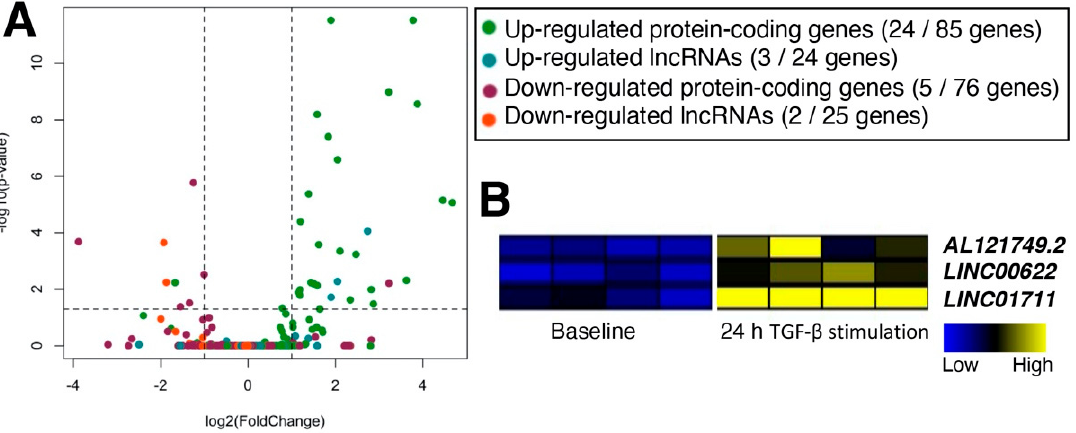
Figure 4. TGF- β -stimulated lncRNAs in cardiac and pulmonary fibroblasts. ( A ) Volcano plot of genes from RNA-seq data of cardiac fibroblasts stimulated with TGF- β for 24 h compared to the CFs before the TGF- β stimulation (baseline). Only genes selected as differentially expressed in pulmonary fibroblasts (CTEPH patients and MRC5 cells treated with TGF- β ) were plotted. Each category of genes is colored as shown in the graph label. In each parenthesis, up- and down-regulated protein or lncRNA genes are shown as the number of genes in cardiac fibroblasts followed by the same category of differentially expressed genes in pulmonary fibroblasts. Dashed lines indicate 2-fold and FDR-adjusted p < 0.05. According to the original publication, human primary atrial fibroblasts were prepared from atrial biopsies of patients undergoing coronary artery bypass grafting. n = 4